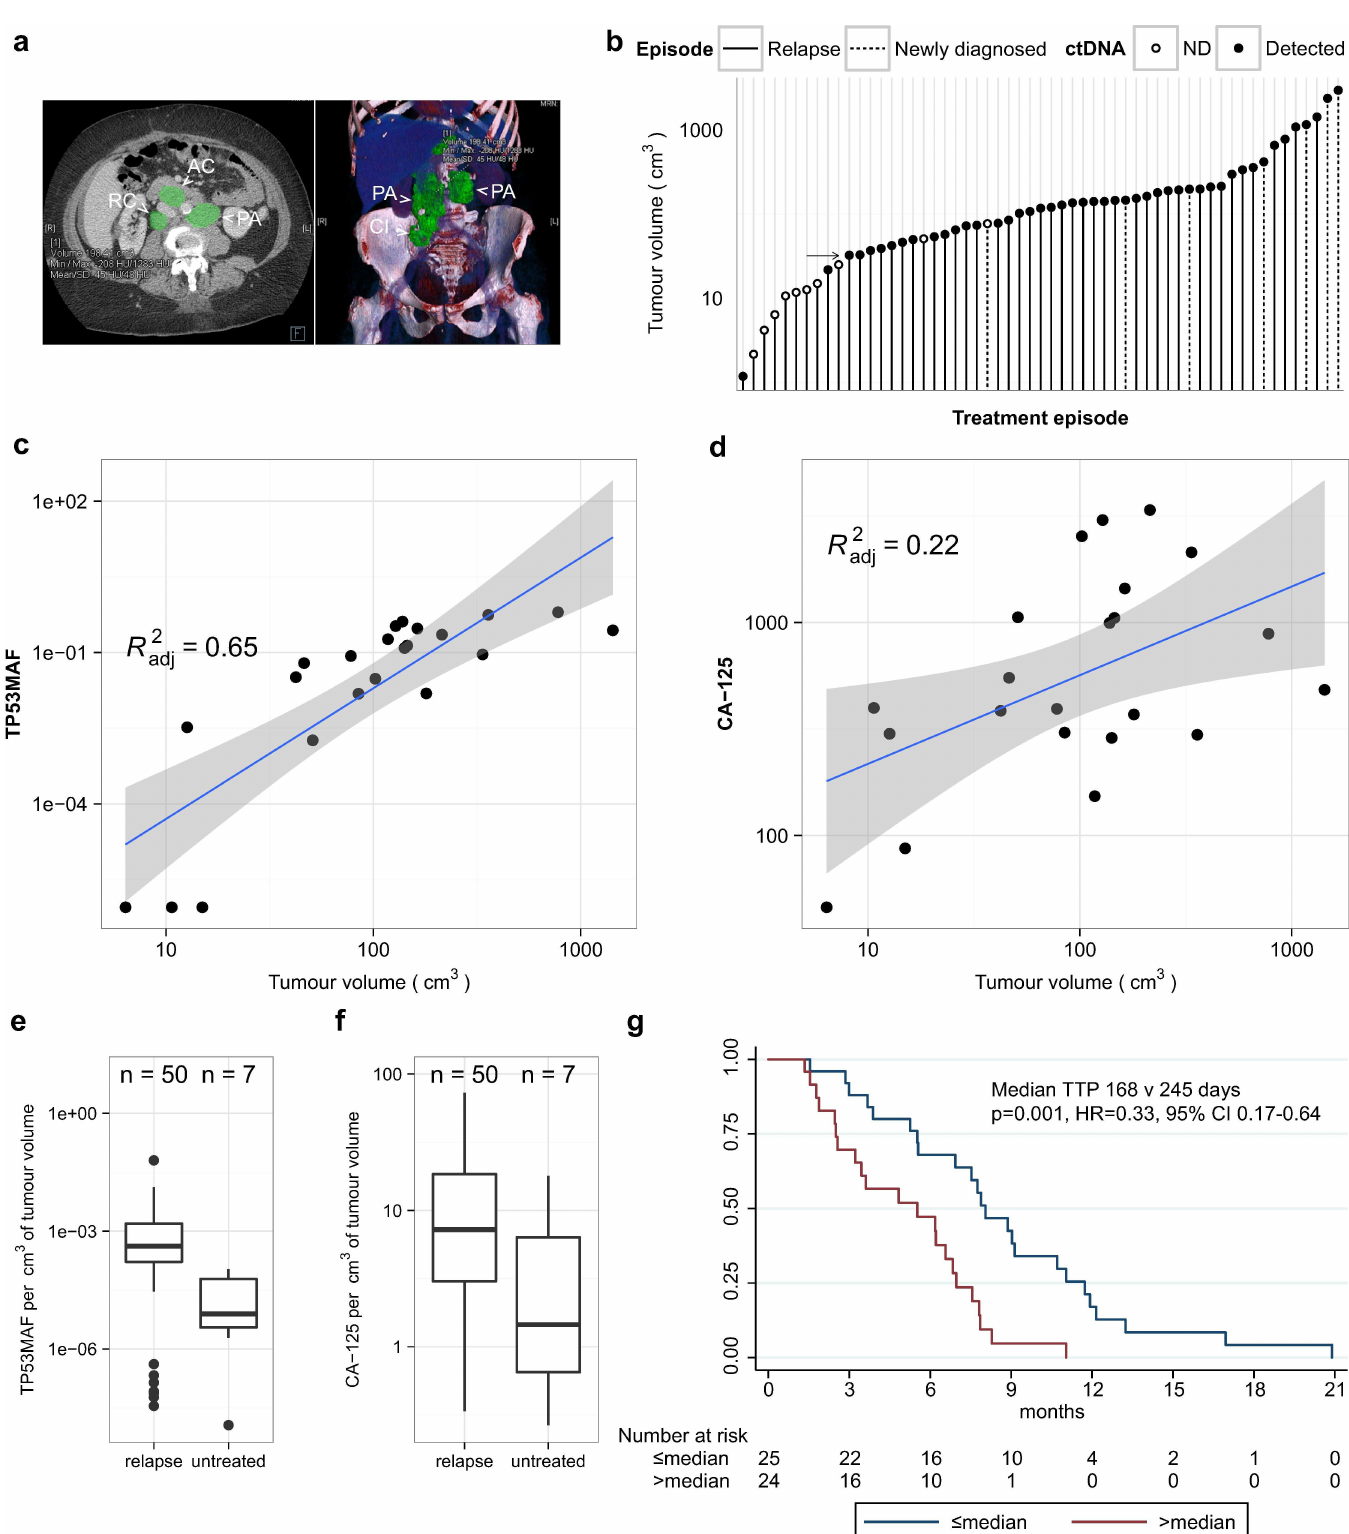
Fig 2. Comparison of TP53 mutant allele fraction to tumour volume. (A) Exampleof volumetricanalysisof high-grade serous ovarian cancer with relapseddiseasein abdominal lymph nodes. Left panelshows cross-sectional view. Right panel shows 3-D reconstruction to show disease volume.Green